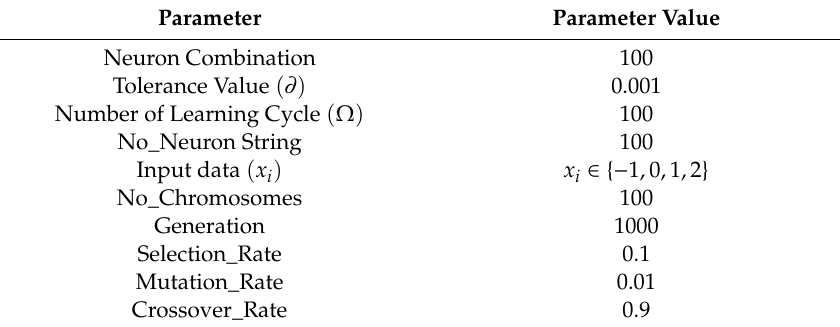
Table 2. List of Parameters in